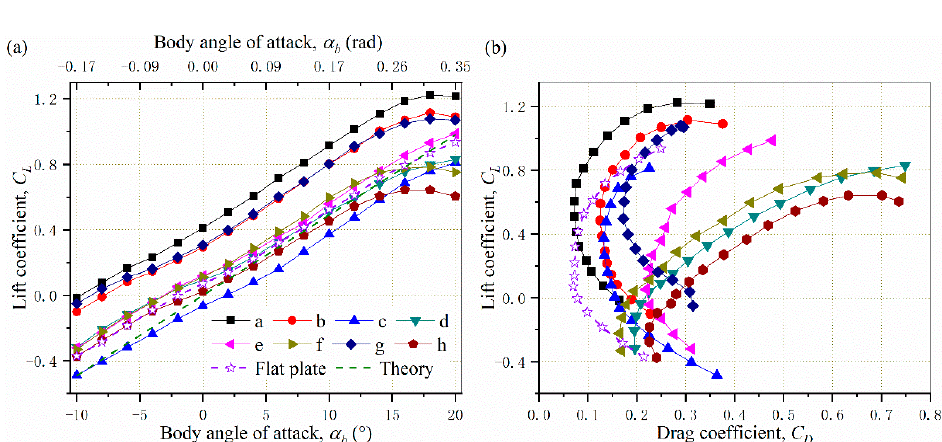
Figure 5. Lift coefficients at different body angles of attack ( a ) and drag coefficient versus lift coefficient ( b ).